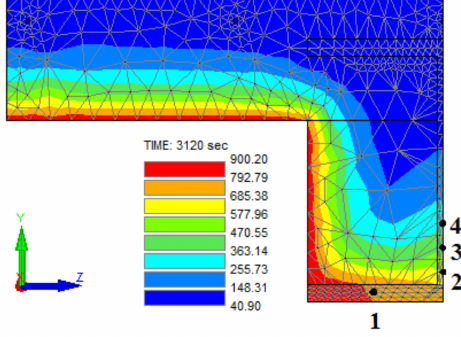
Figure 5. Cross-section of the WFRC 44174 test.